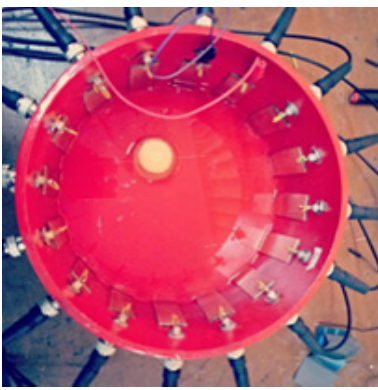
Figure 16. Phantom object.